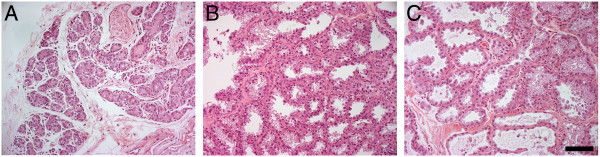
Hematoxylin- and eosin-stained mammary biopsy samples from rhesus macaques. Histology of tissue biopsied from the mammary glands of rhesus macaques at different stages of lactation. Sections (4 μm) were stained with hematoxylin and eosin. Scale bar = 100 μm. (A) Multiparous aged female macaque, non-pregnant, non-lactating; (B) multiparous female macaque, lactation day 30; and (C) multiparous female macaque, lactation day 90.